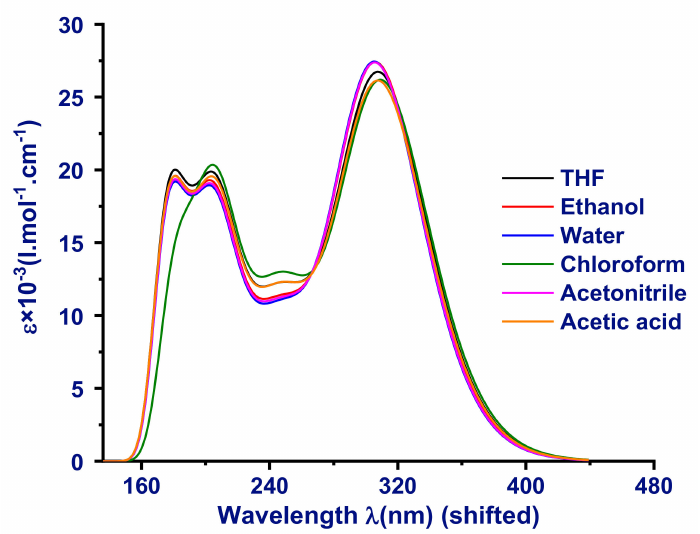
Figure 6. Computed UV-abs spectra at TD-DFT B3LYP/6-31+G(d) level as a function of several